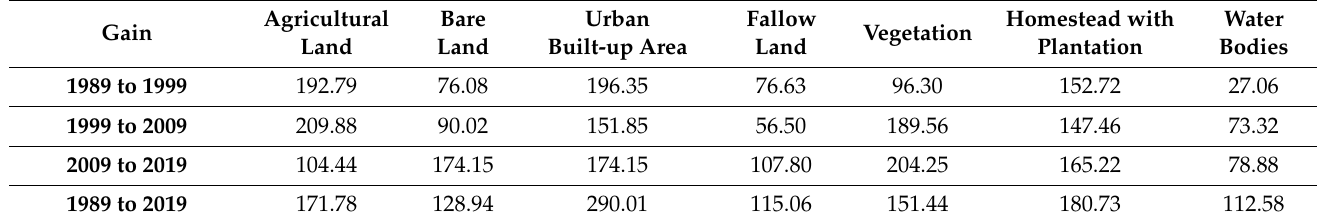
Table 11. Account for areal gains (km 2 ) per LULC elements over the time.